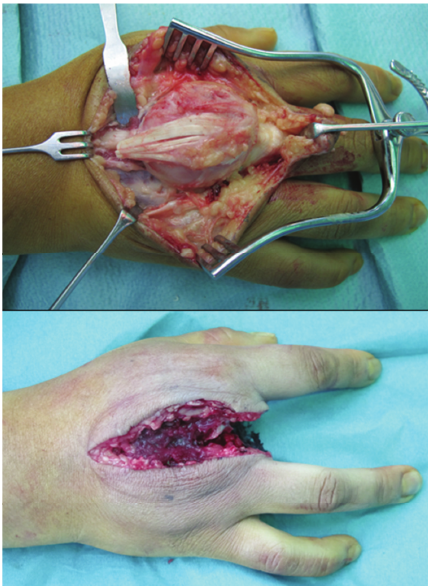
Figure 8: Dorsal longitudinal approach to the third metacarpal showing the dorsal tumor. Amputation of the third metacarpal.